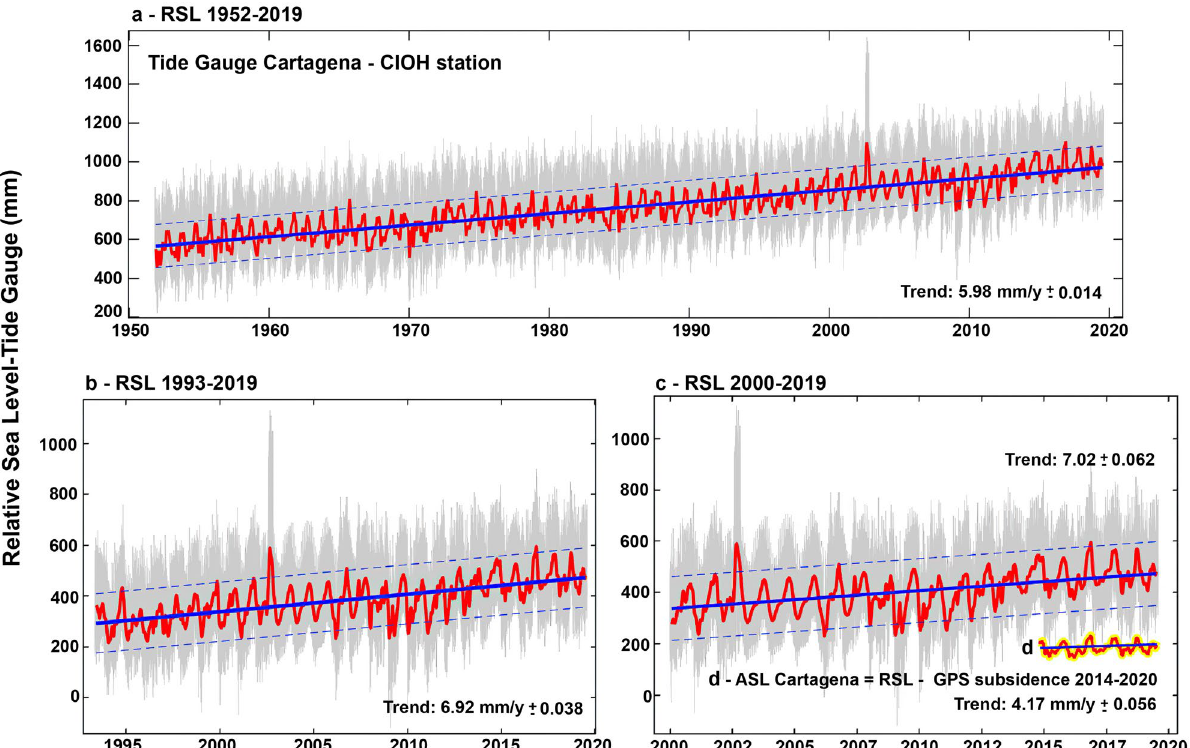
Figure 2. Time series of monthly relative sea level (RSL) data at the tide gauge in Cartagena for time spans 1952–2019 ( a ), 1993–2019 ( b ), and 2000–2019 ( c ), after being pre-processed to remove extremes and reconstruct gaps. ( d ) We include the absolute sea level trend (ASL) from 2014 to 2019 obtained after subtracting the GPS subsidence rate at the tide gauge. This new trend (4.17 ± 0.05 mm/yr) represents the steric component of RSL in Cartagena ( d , red line with yellow highlight). We also show linear trends in RSL (blue) and data with a low-pass cosine-Lanczos filter and a cut-off period of 28 days (red) (see “Methods”). Data from the University of Hawaii Sea Level Center (UHSLC, https:// uhslc. soest. hawaii. edu/) and the Oceanographic and Hydrographic Research Institute (CIOH) in Cartagena. Tide gauge plots generated by Matlab 2019b (https:// www. mathw orks. com/ produ cts/ matlab.